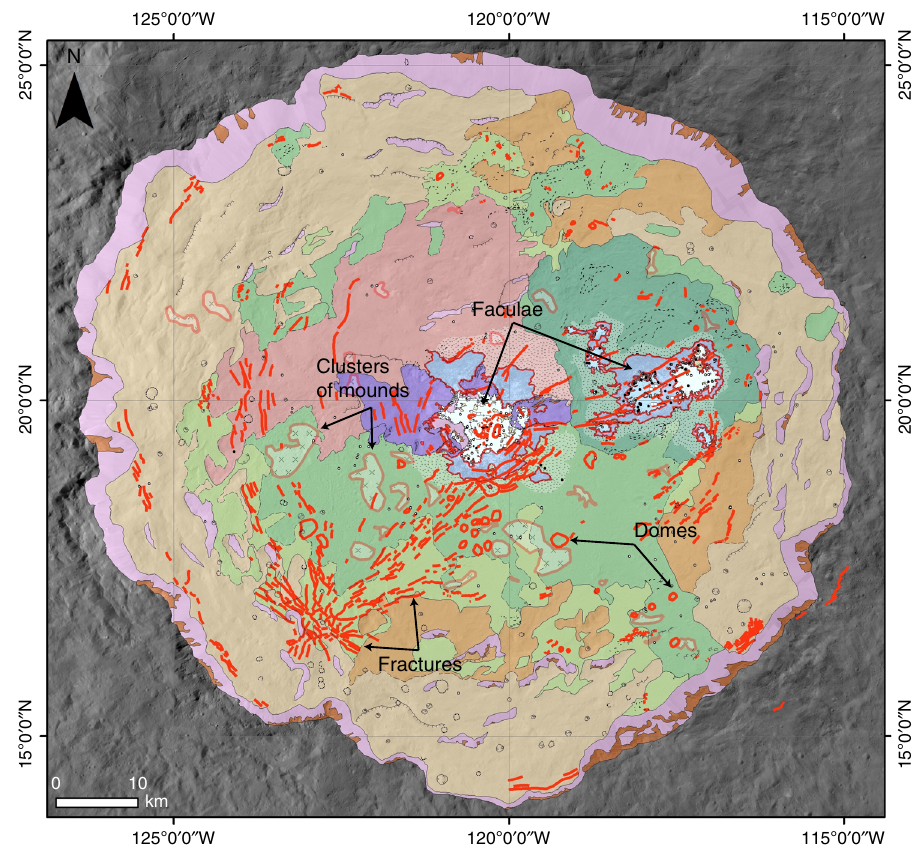
Fig. 3 Clustering of features within Occator. Our XM2-based geologic map (colors and symbols the same as in Fig. 1a) with fractures, faculae, domes, and mounds highlighted in red. Examples of each feature are labeled. The fractures, faculae, domes, and mounds tend to occur in the same regions of the crater fl oor.